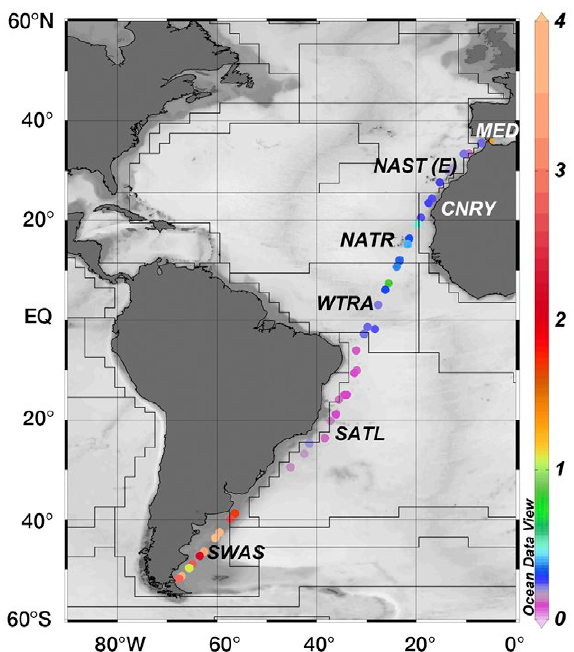
Fig. 1. – Position and biogeochemical provinces (Longhurst, 2007) of the sampling stations of the TransPEGASO cruise (21/10/2014- 21/11/2014). The province names and abbreviations are: Mediter- ranean (MEDI), Atlantic Subtropical Gyre East (NAST- E), Canary Current Coastal (CNRY), North Atlantic Tropical Gyre (NATR), western tropical Atlantic (WTRA), South Atlantic Tropical Gyre (SATL) and Southwest Atlantic Continental Shelf (SWAS). The color scale indicates Fl_Chl a in mg m –3